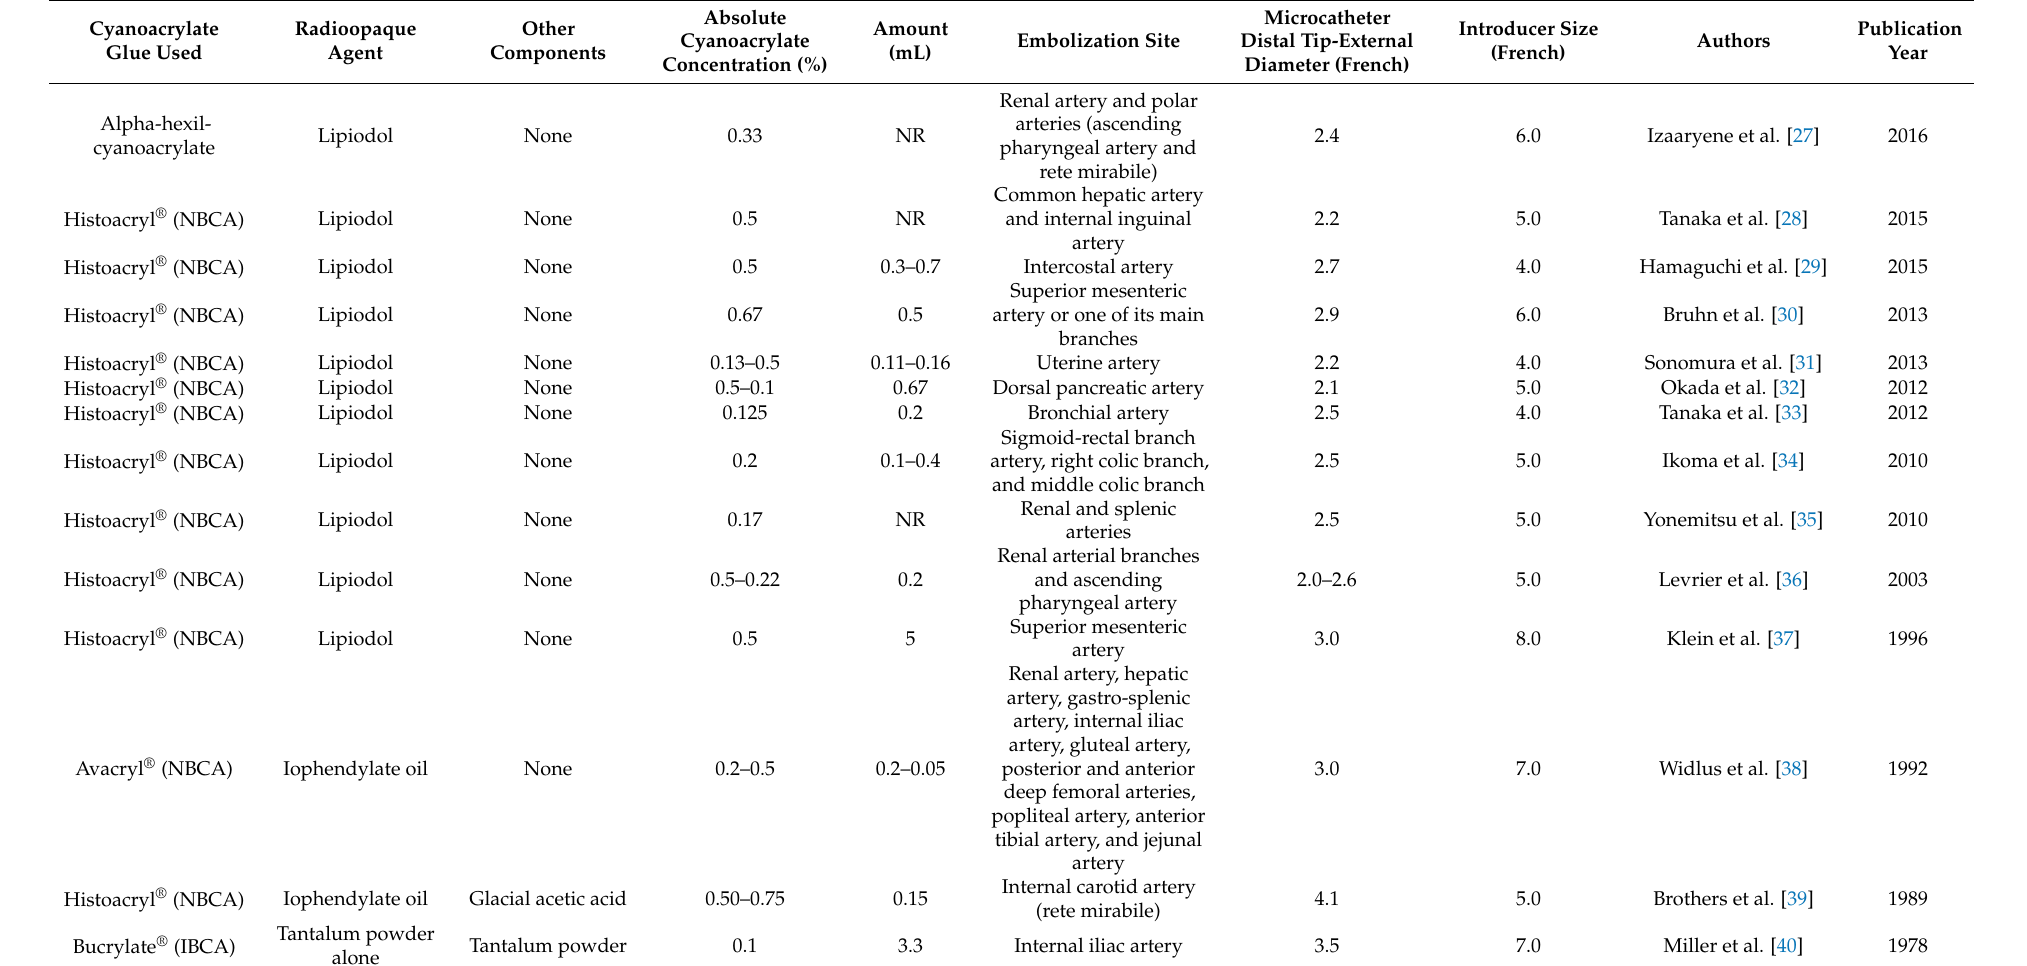
Table 2. Quantitative data from studies of swine